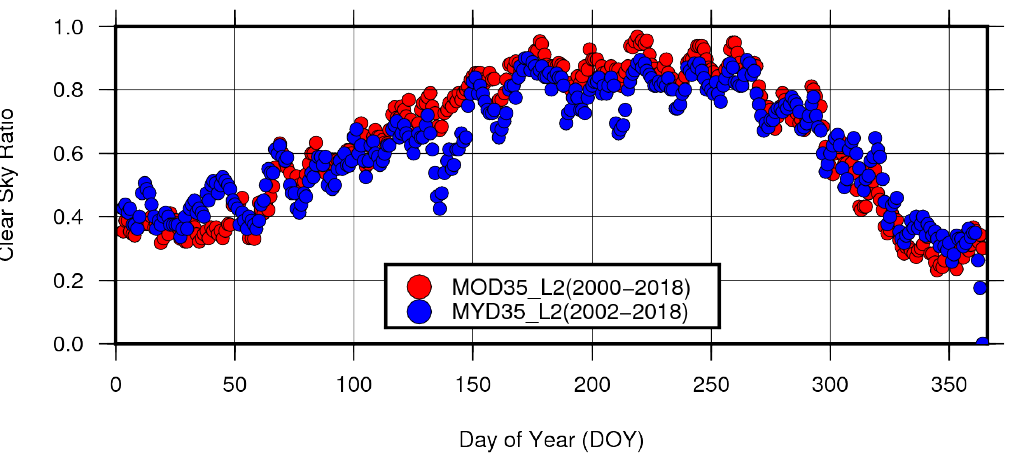
Figure 3. Mean value of clear sky ratio r ( t ) over Railroad Valley